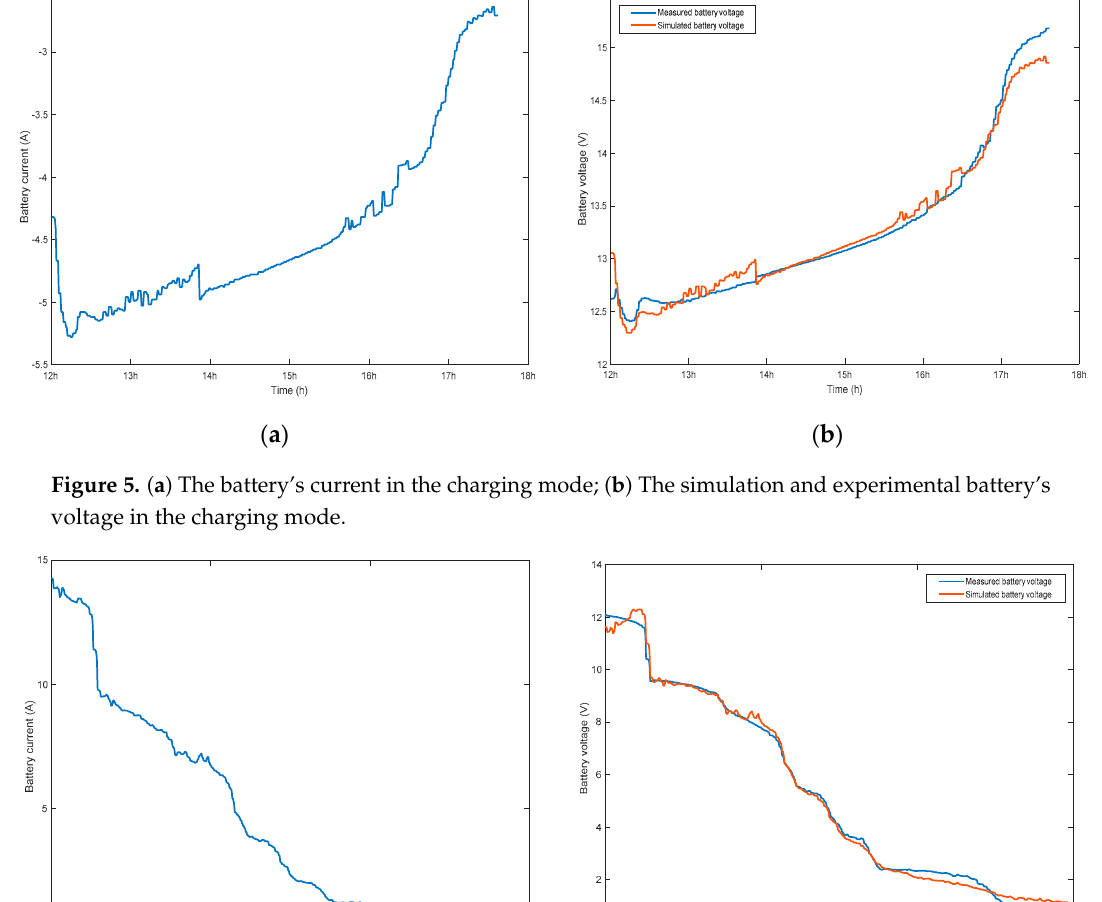
Figure 7. The MG Simulink model used for simulations.